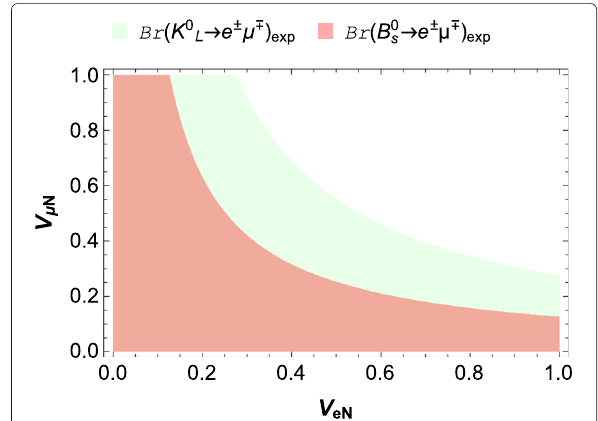
Fig. 6 The allowed parameter space in scenario D, in which we have taken m N = 70GeV as an illustration